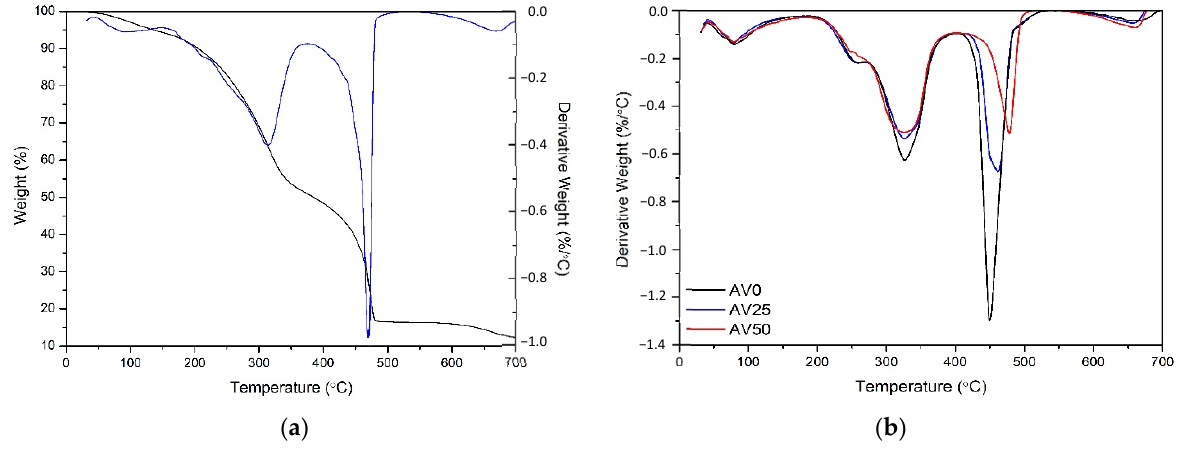
Figure 3. ( a ) TG-DTG curves of as-received Aloe vera ; ( b ) DTG curves of AV0, AV25, and AV50.